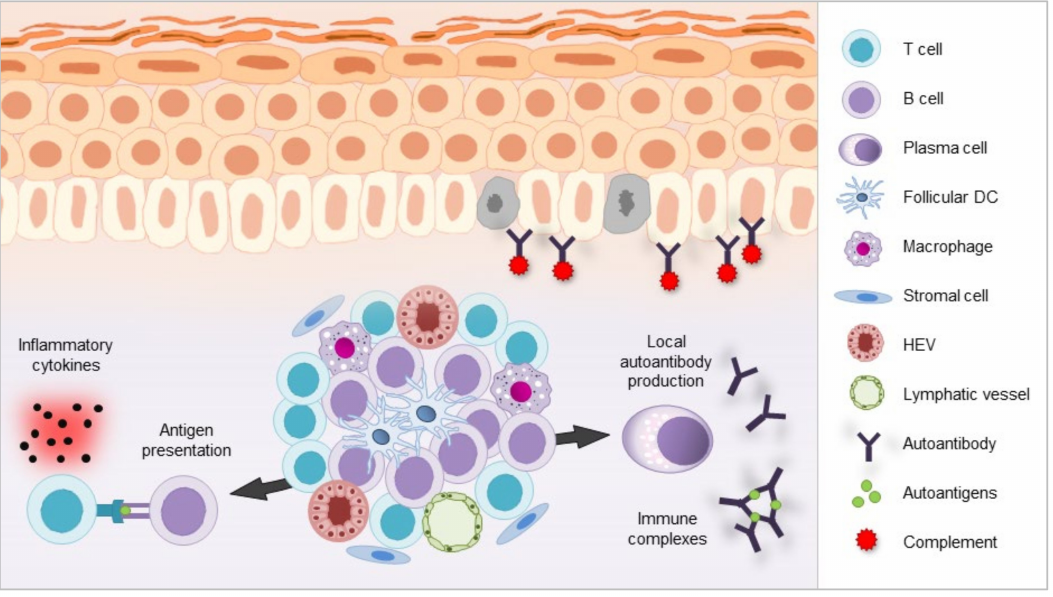
Figure 1. Schematic illustration of a potential tertiary lymphoid structure (TLS) in skin autoimmunity. TLS represent accumulations of lymphoid and stromal cells arising at ectopic sites as a reflection of chronic inflammation. As depicted, they may consist of B- and T-cell clusters and a network of stromal cells, follicular dendritic cells (DC) and macrophages as well as vascular structures such as high endothelial venules (HEV) and lymphatic vessels, possibly forming GC-like structures [12,116,117,119]. TLS may create a microenvironment that enables localized autoantigen-directed immune responses such as T cell activation, which might also be driven by B cells with antigen-presenting